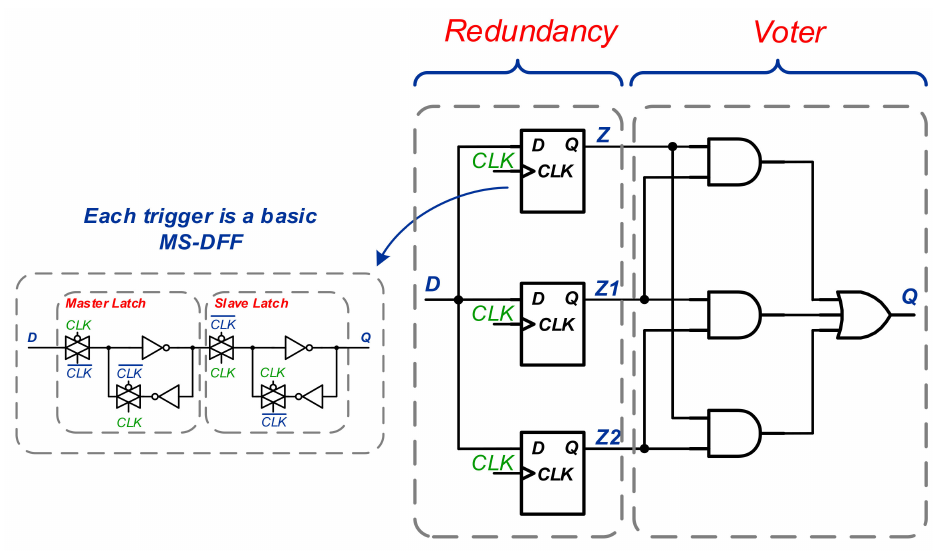
Figure 6. Schematic diagram of TMR-DFF.